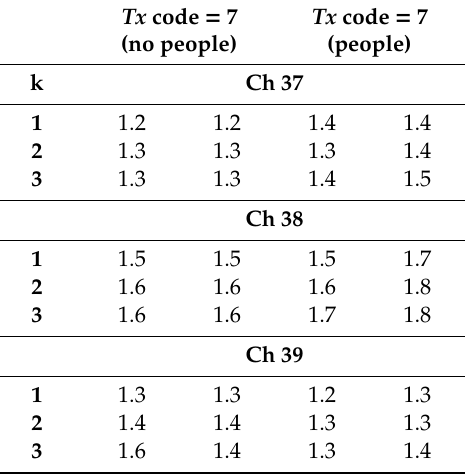
Table 9. Comparison of accuracies (in m) for Tests #2a and #2b. For each option, the first and second data columns refer to the iBeacon and Eddystone protocol respectively. The three advertising channels are referred to as Ch 37, etc., and the number of neighbors in the WKNN algorithm, as k . Tx code = 7 Tx code = 7 (no people) (people)